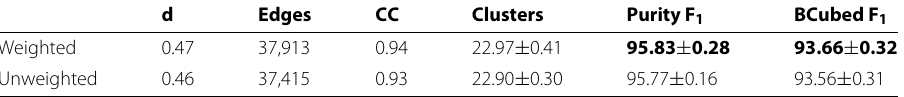
Table 2 Semantic frame induction results according to the weighting of the edges d Edges